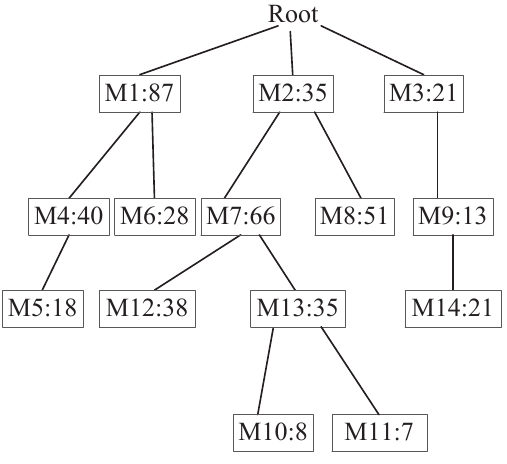
Figure 5. T-pattern